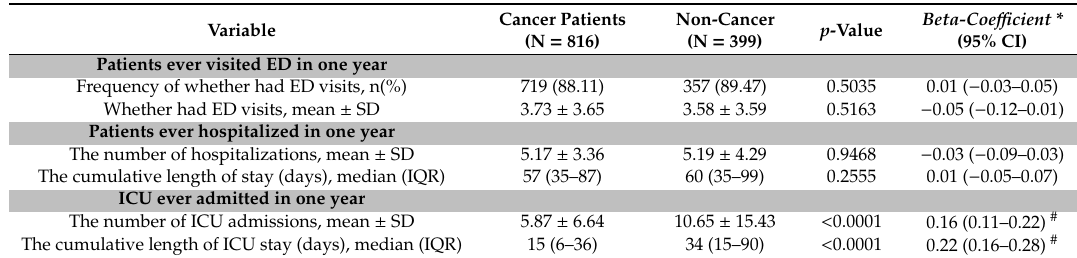
Table 2. The utilization of healthcare resources for the frequency of ED visits, the number of hospitalizations, and the number of ICU admissions in COPD patients with and without cancer within one year before the inpatient date of